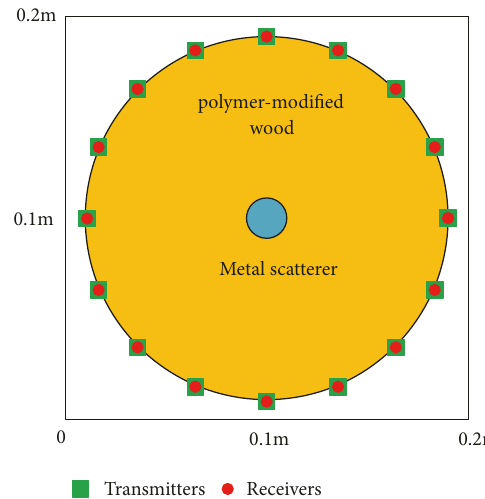
Figure 4: Single circular metal defect model.